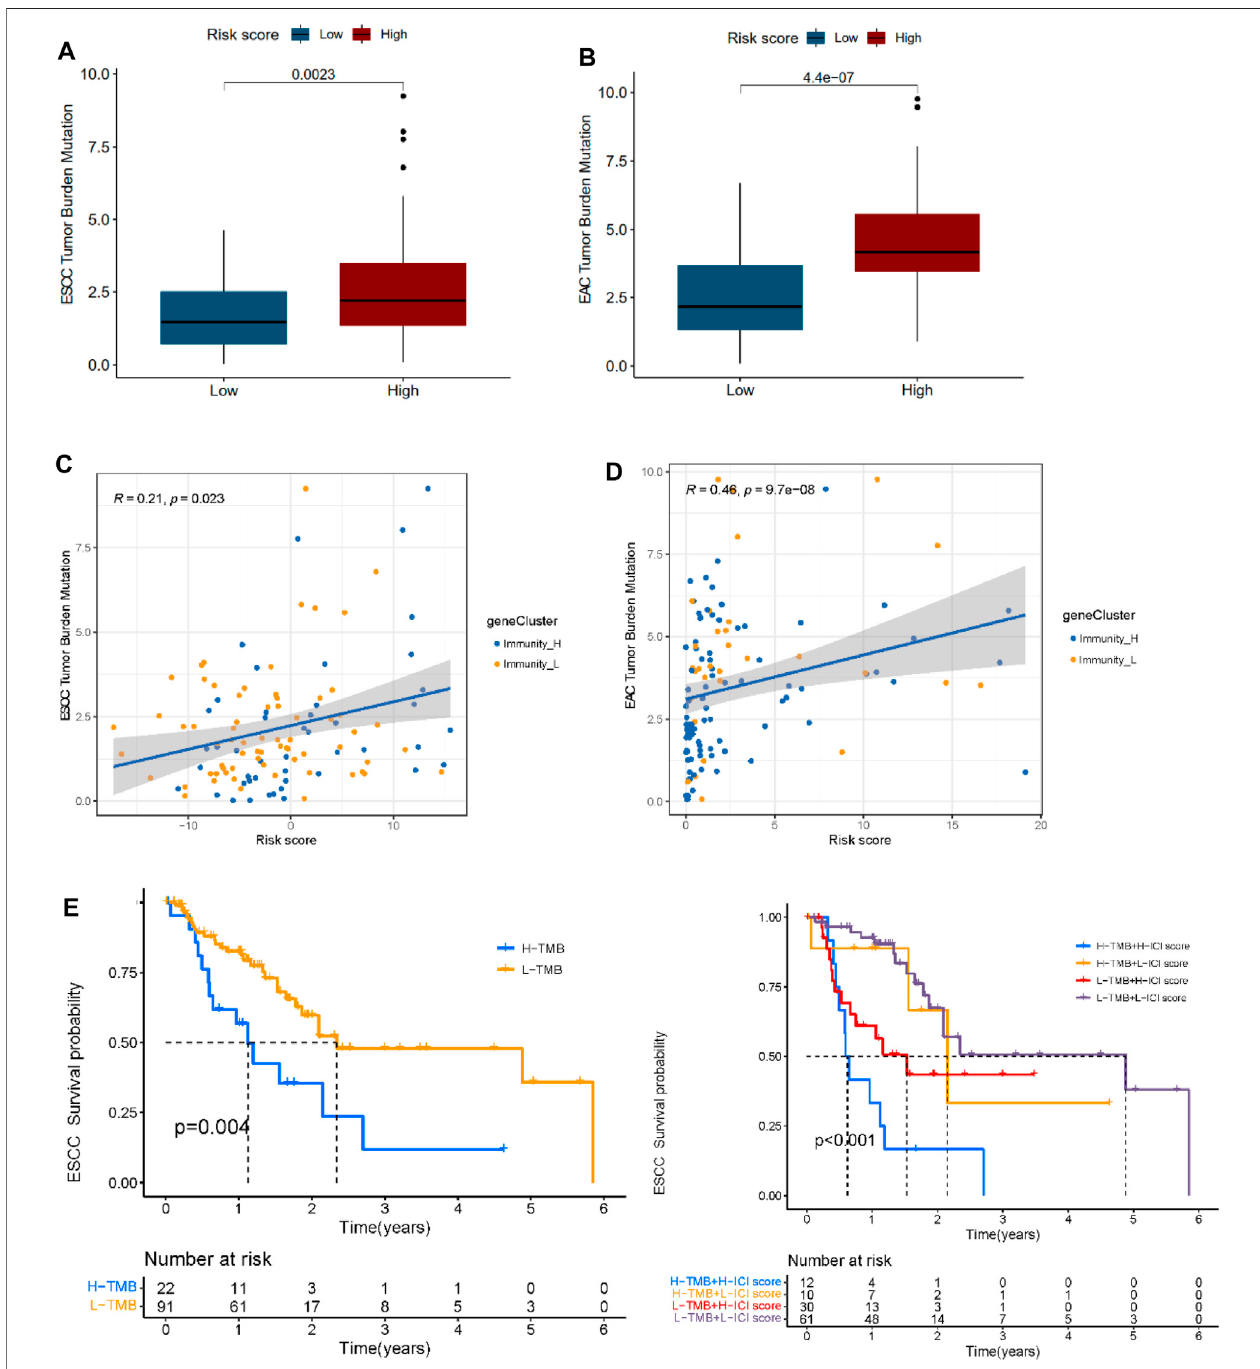
FIGURE 7 | Correlation between tumor mutation burden (TMB) and risk score. (A) Differential TMB in high- and low-risk groups in ESCC. (B) Differential TMB in high- and low-risk groups in EAC. (C) Linear correlation between TMB and risk score in ESCC. (D) Linear correlation between TMB and risk score in EAC. (E) Survival curves of high and low TMB groups and TMB-risk combined survival curves in ESCC. (F) Survival curves of high and low TMB groups and TMB-risk combined survival curvesinEAC. (G) Waterfallplotoftop20mutantgenesinthehigh- andlow-riskgroupinESCC. (H) Waterfallplotofthetop20mutant genesinthehigh-andlow- risk group in